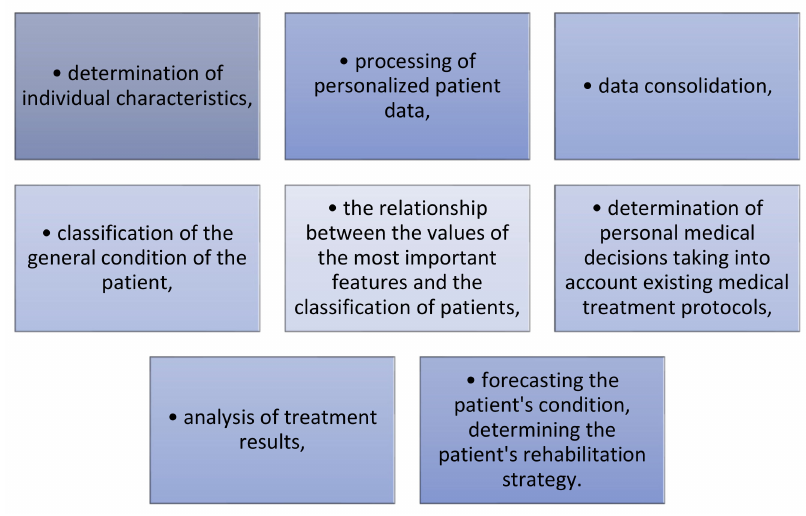
Figure 1. The main stages of patients’ information